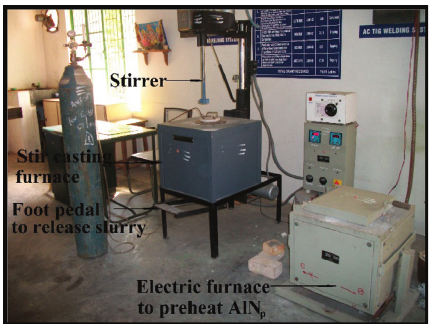
Figure 1: Modified electric stir casting furnace with the bottom pouring attachment and the electric furnace used to preheat Si 3 N 4.